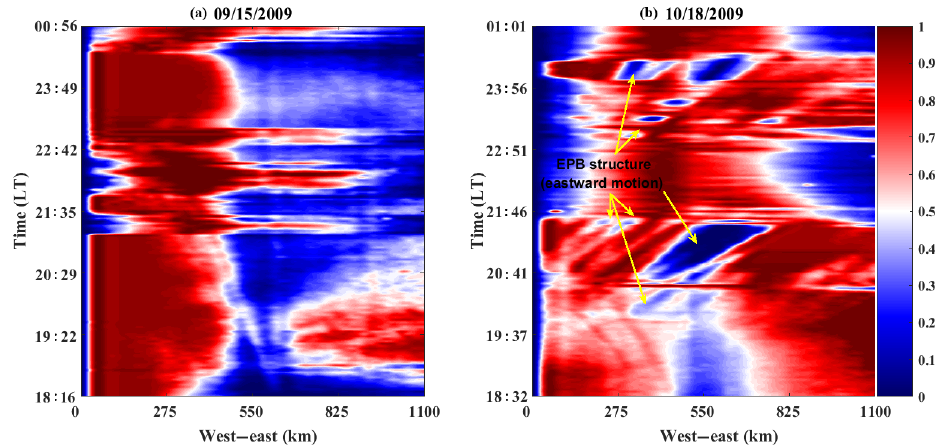
Figure 5. Keograms for 15 September 2009 (a) and 18 October 2009 (b)